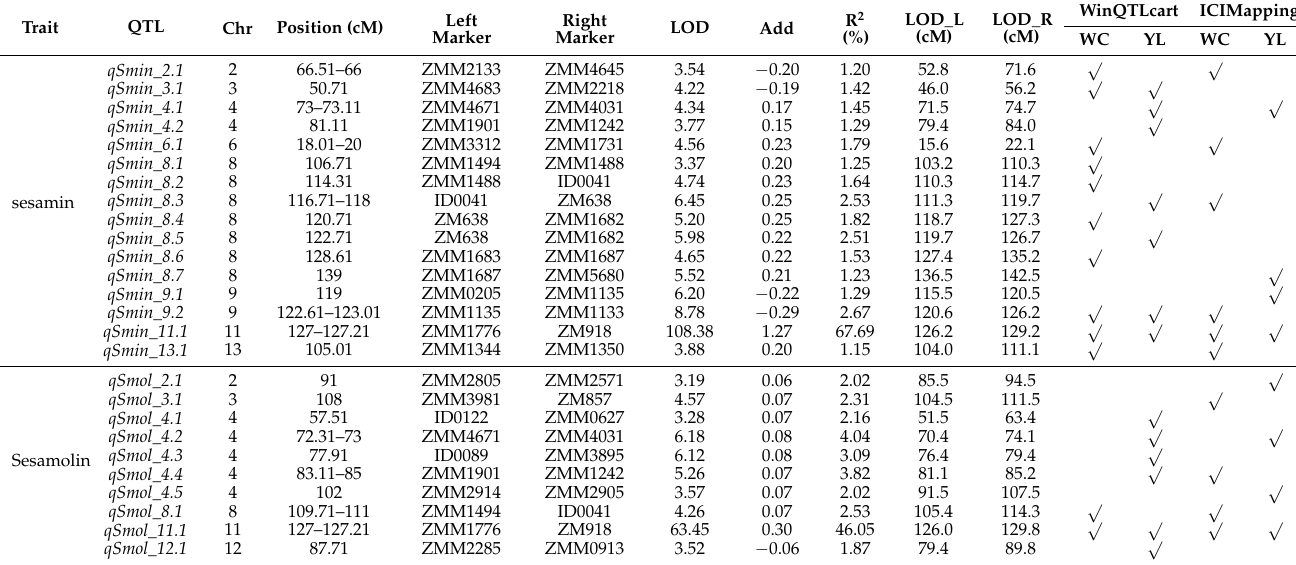
Table 3. Additive effect QTLs for sesamin and sesamolin based on phenotyping under two environments Wuchang, Yangluo, and detected using Windows QTL Cartographer version 2.5 and QTL IciMapping